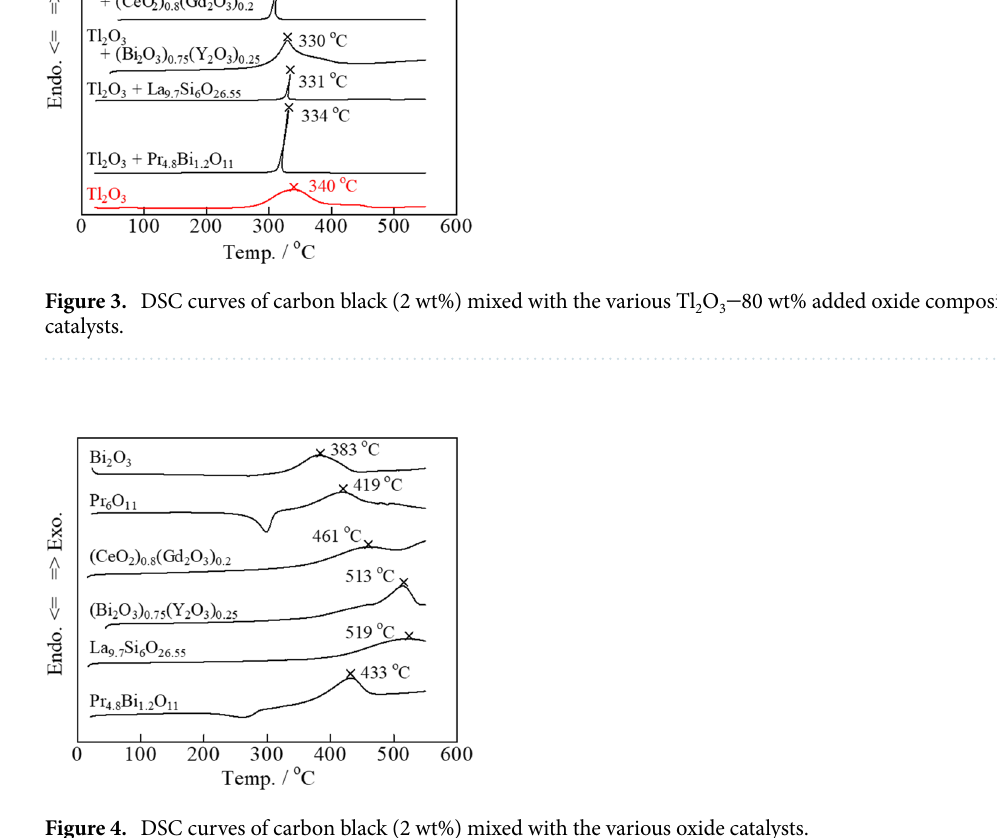
Figure 4. DSC curves of carbon black (2 wt%) mixed with the various oxide catalysts.